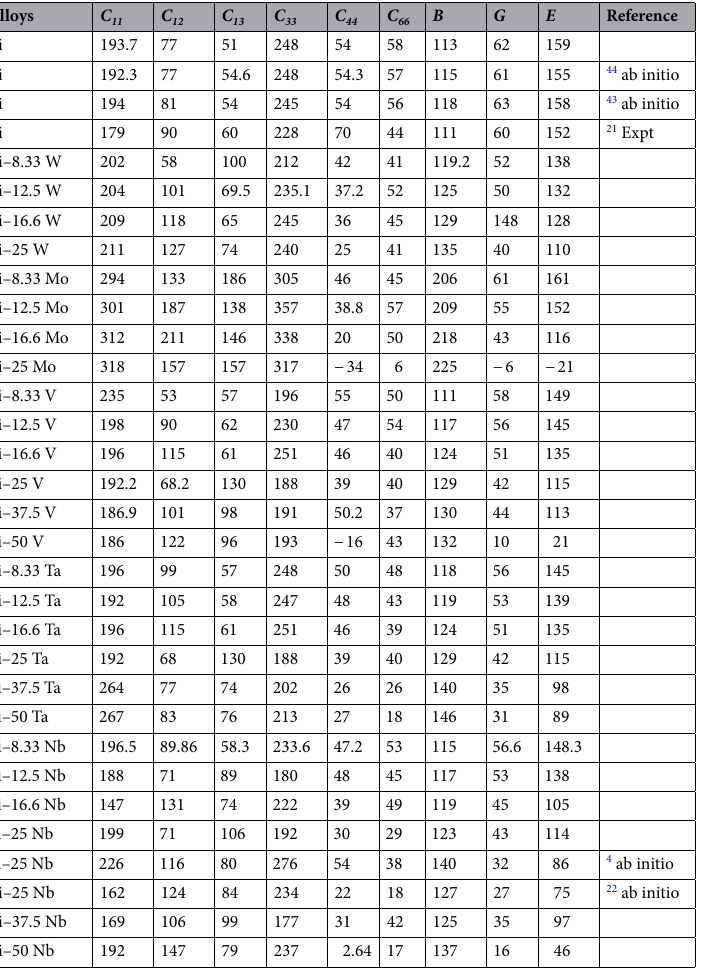
Table 6. The elastic constants of ω-phase in Ti–X binary systems (X = W, Mo, V, Ta, and Nb) at 0 K obtained using first-principles calculated. The single crystal elastic constants c ij , bulk modulus B , shear modulus G , and Young’s modulus E are all in